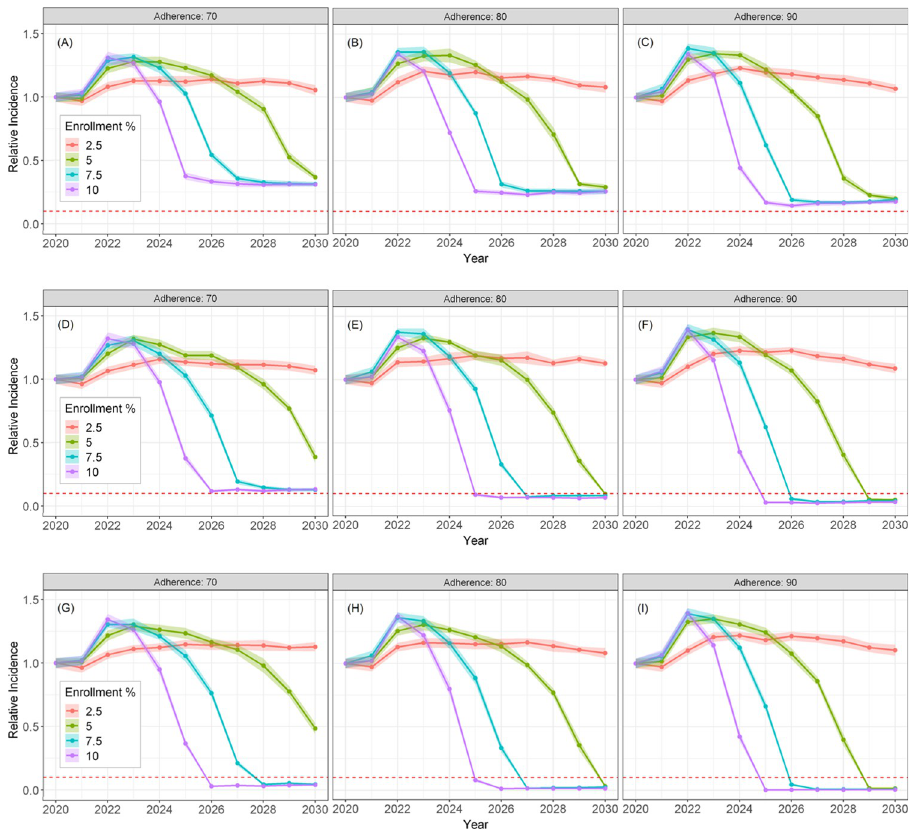
Fig 6. Projected HCV mean incidence of new chronic infections among PWID relative to the predicted 2020 incidence for 1–2 DAA treatment courses permitted (A-C), 2–3 DAA treatment courses permitted (D-F), and 1–4 DAA treatment courses permitted (G-I). Treatment adherence ranges from 70%-90% as indicated by the figure titles. The ribbons represent the 95% confidence interval around the mean of 20 simulation runs. The horizontal red dashed line represents the WHO 2030 goal of 90% reduction in the incidence